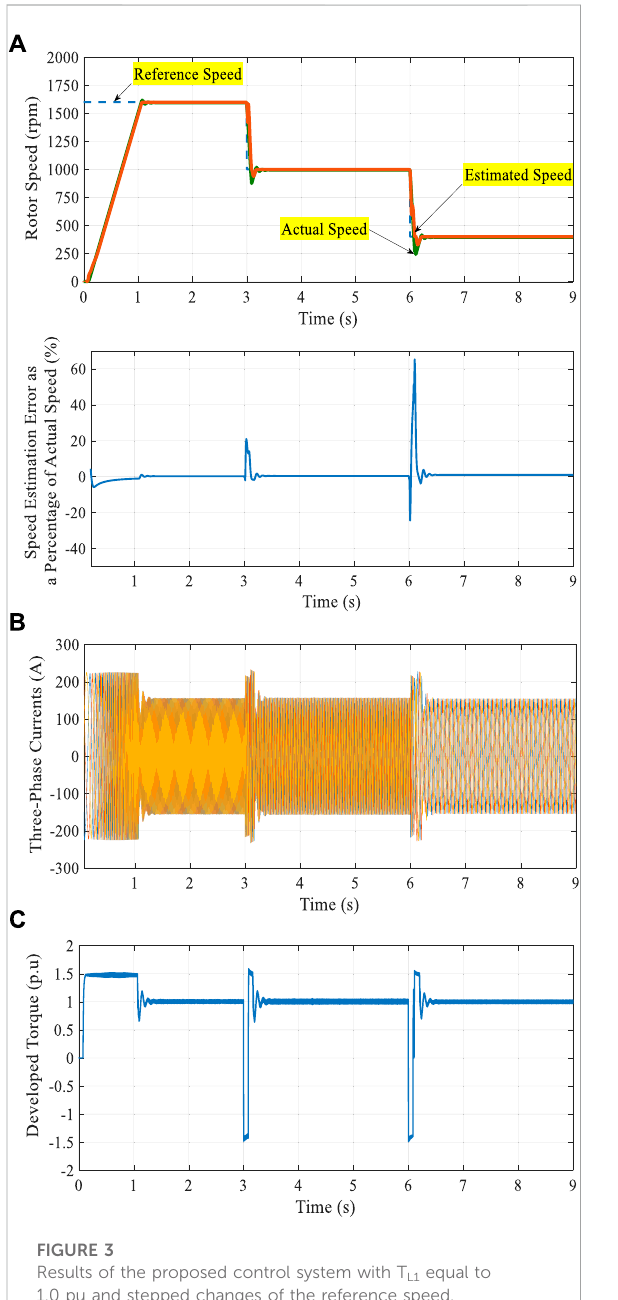
FIGURE 3 Results of the proposed control system with T L1 equal to 1.0 pu and stepped changes of the reference speed.